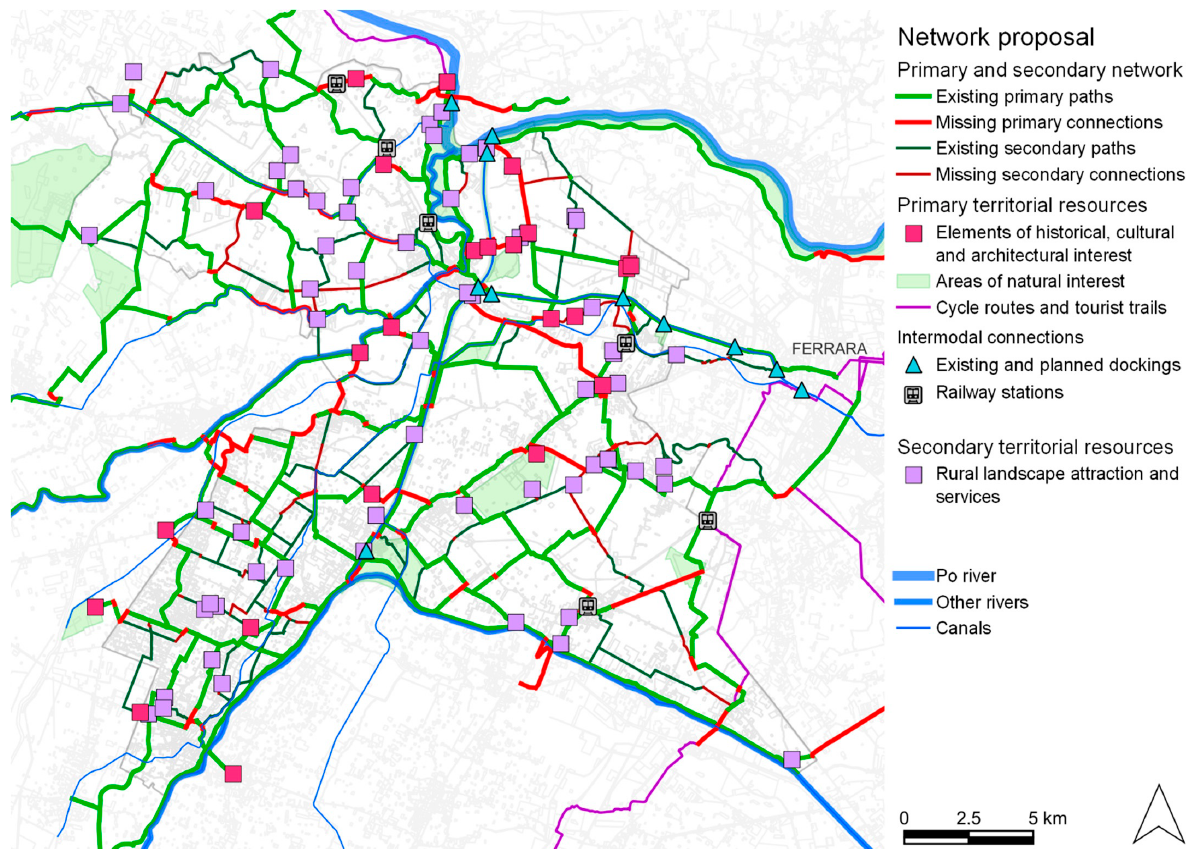
Figure 8. The proposed soft mobility network.